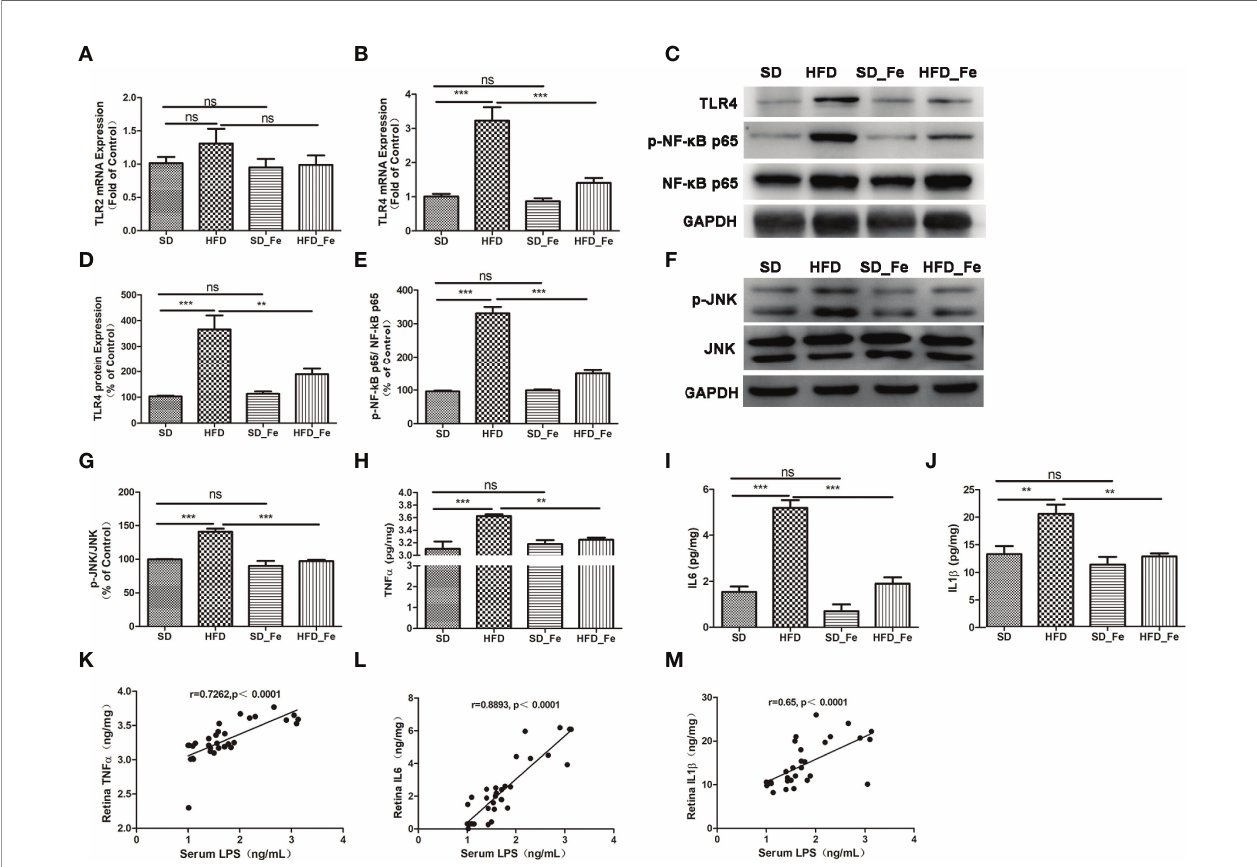
FIGURE 4 | Effect of feno fi brate on the TLR2/4 signaling pathway and in fl ammatory factors in the retina of high-fat diet (HFD)-fed mice. (A, B) TLR2 (A) and TLR4 (B) mRNA expression levels in retina. (C – E) Representative images (C) and statistical analysis of Western blot showed the TLR4 protein levels (D) and the ratio of p- NF-kB p65/NF-kB p65 (E) in retina. (F, G) Representative images (F) and statistical analysis (G) of Western blot showed the ratio of p-JNK/JNK in the retina. (H – J) In fl ammatory factors TNF a (H) , IL6 (I) and IL1 b (J) levels in retina. (K – M) Correlations between serum LPS and TNF a (K) , IL6 (L) and IL1 b (M) in retina, respectively. When correlation coef fi cient “ |r| ” ≥ 0.349 (n = 32) and p < 0.05, there were signi fi cant correlations between the two indicators. SD group, standard diet group; HFD group, high-fat diet group; SD_ Fe group, standard diet plus feno fi brate group; HFD_ Fe group, high-fat diet plus feno fi brate group. n = 5 (A – G) , n = 8 (H – M) ; ns, not signi fi cant; **P < 0.01; ***P < 0.001. Bar graphs represent mean values ±